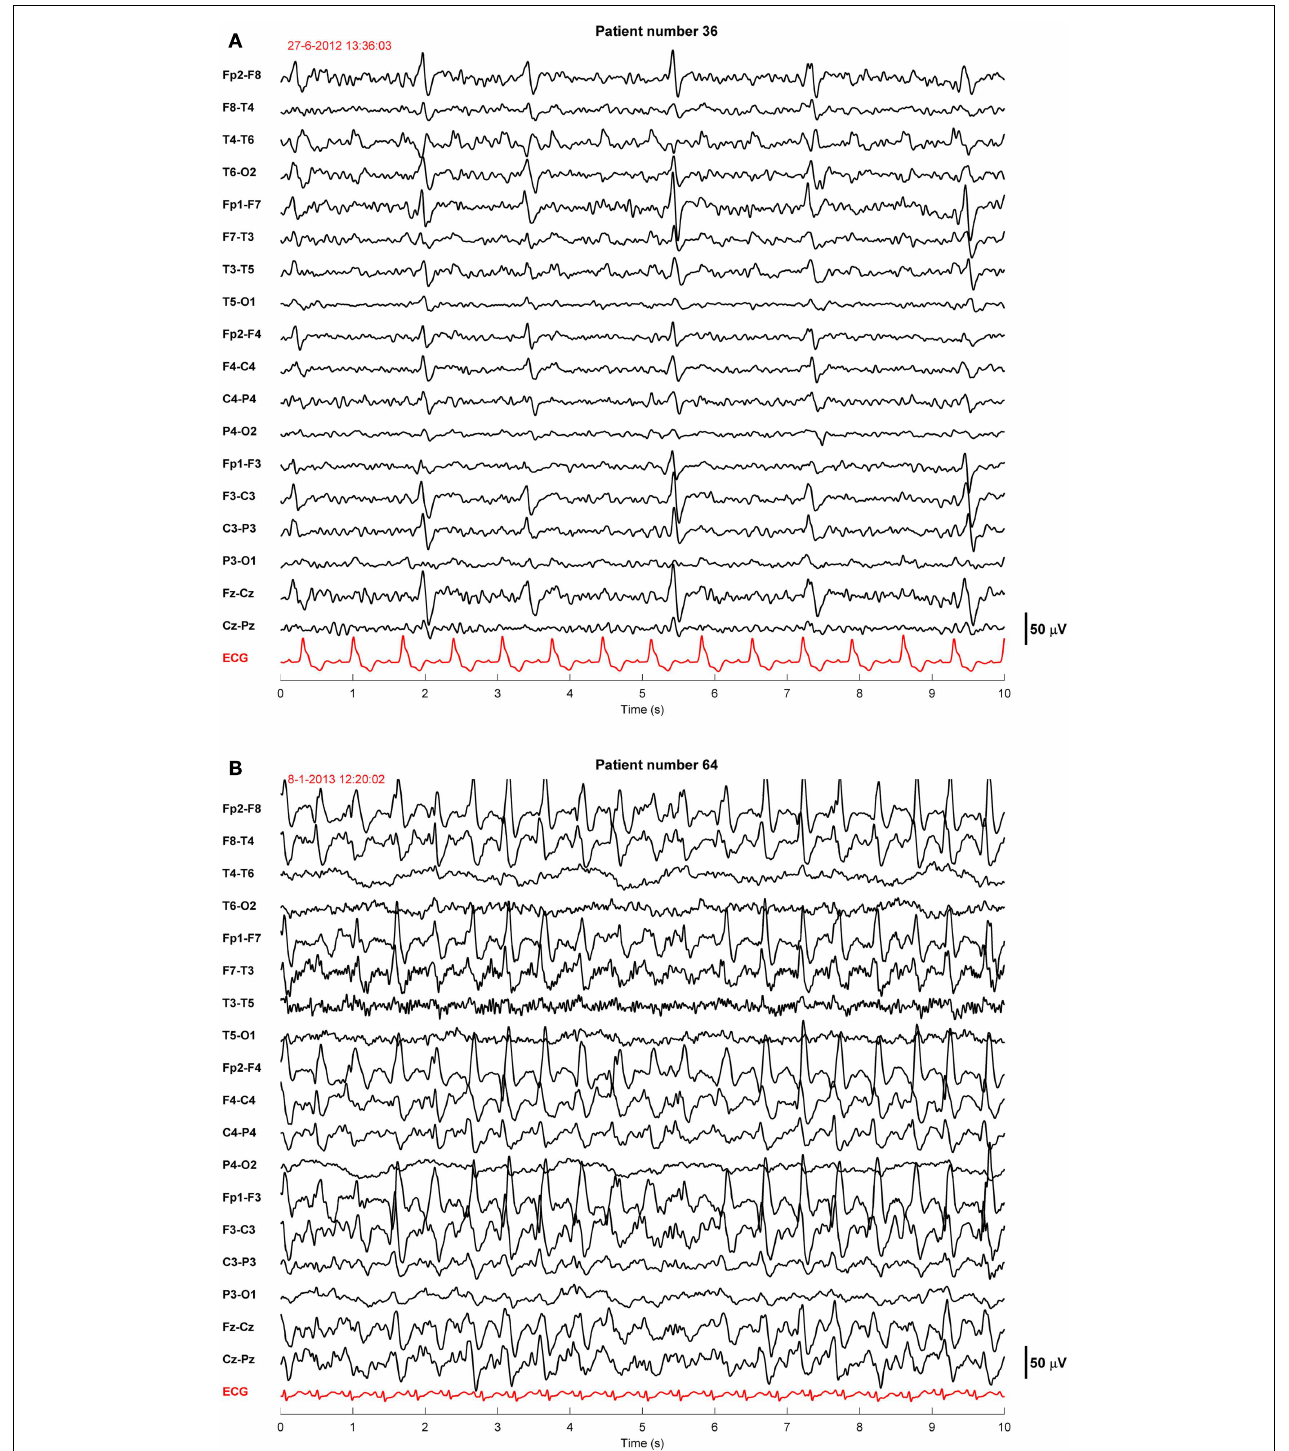
FIGURE 2 | Examples of EEGs of two comatose patients after cardiac arrest showing generalized periodic discharges .These patients were normothermic and sedated with propofol 1–2.5mg/kg/h.The EEG epochs were recorded 46h (A) or 68h (B) after cardiac arrest. Filter settings, 0.5–30Hz. These patients had a poor